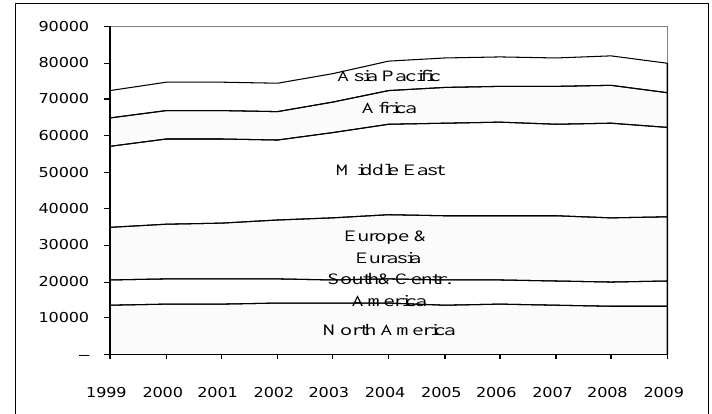
Figure 3: World Oil Production (Thousand Barrels Daily) – 2009